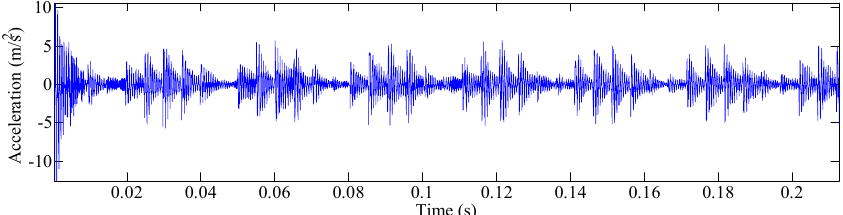
Figure 3. The acceleration response when the defect is on the inner raceway.